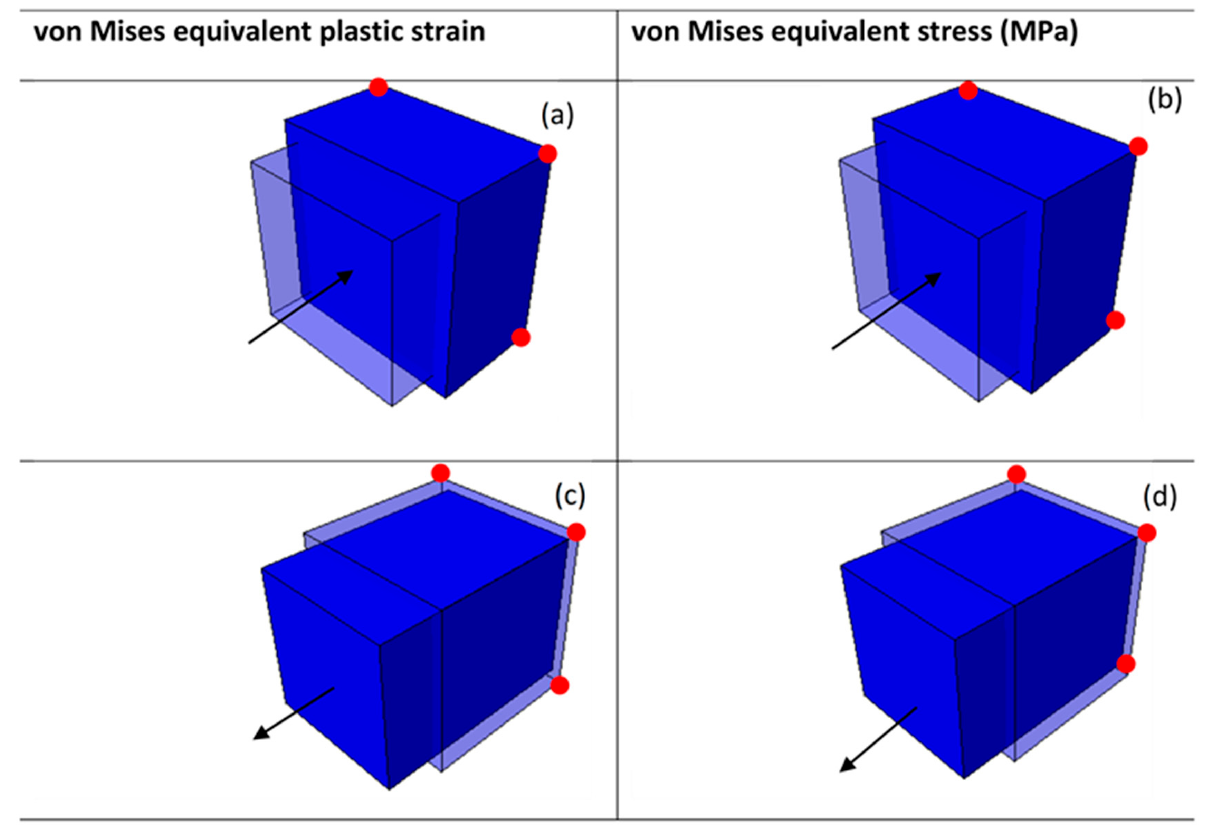
Figure 4. A typical VUHARD deformed 8-node linear brick element at a temperature of 298 K and velocity of 4 m/s in ( a , b ) compression and ( c , d ) tension for sample type C. The arrows show the loading direction, while the red dots are the roller supports.